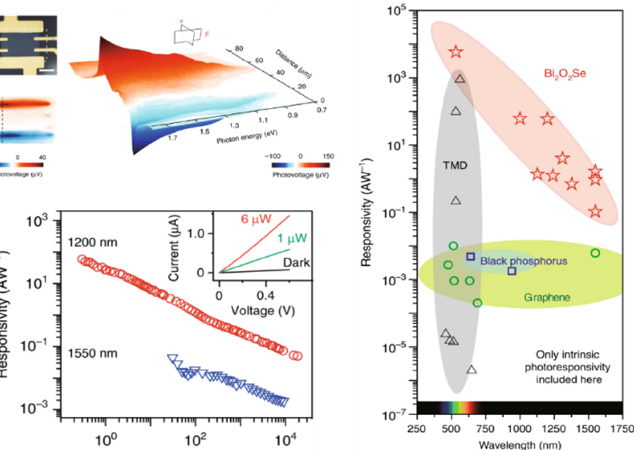
Figure 14. Optical image of a device based on Bi 2 O 2 Se ~ 10 nm-thick (~ 16 layers), scale bar 20 μ m ( top left ). Scanning a photovoltaic device in the area marked with a dotted rectangle with a 1200 nm laser at 150 μ W, recording the photovoltage as a function of the laser position without external bias ( top middle ). The spectrogram was obtained from the scanned photovoltage lines at various energies of the incident photons. Dependence of the photosensitivity of a 2D Bi 2 O 2 Se photodetector at a bias of 0.6 V at wavelengths of 1200 and 1500 nm on the incident power and bias voltage at a wavelength of 1200 nm ( bottom left ). Comparison of photodetectors based on Bi 2 O 2 Se, graphene, black phosphorus and transition metal dichalcogenides (TMD) (on right ). The data include only the generation of a photocurrent due to the excitation of interband transitions without additional processing, such as the addition of waveguide or plasmonic structures [45].